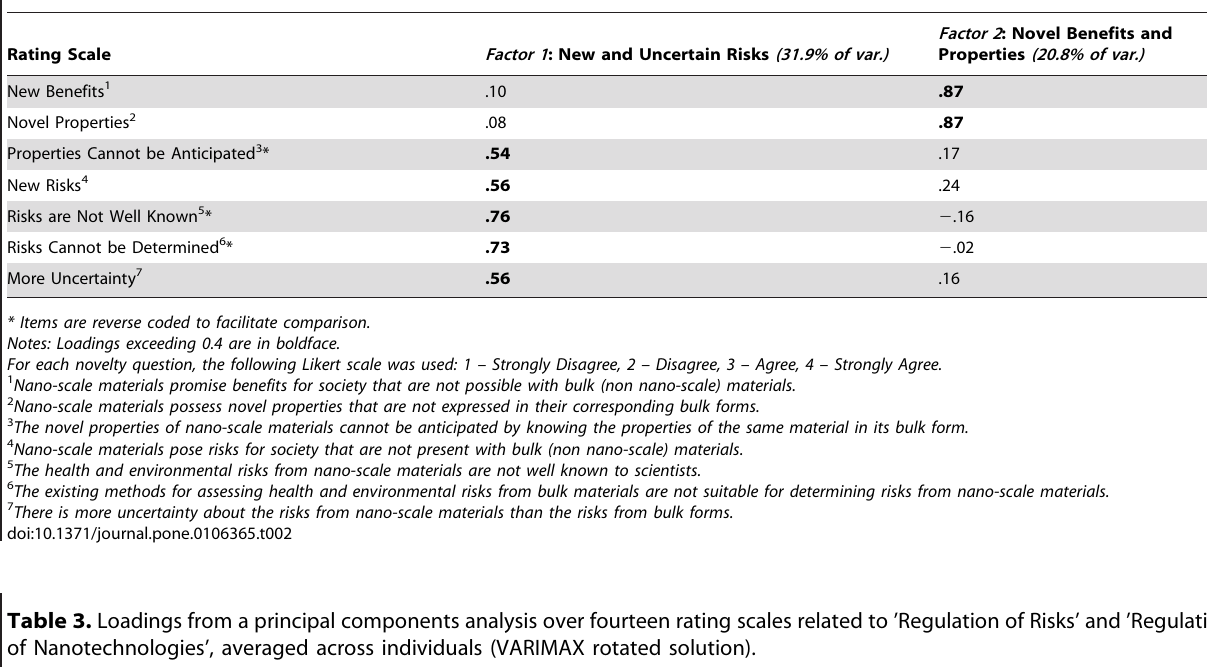
Factor 1: Confidence in Markets and Voluntary Regulation (33.7%ofvar.)